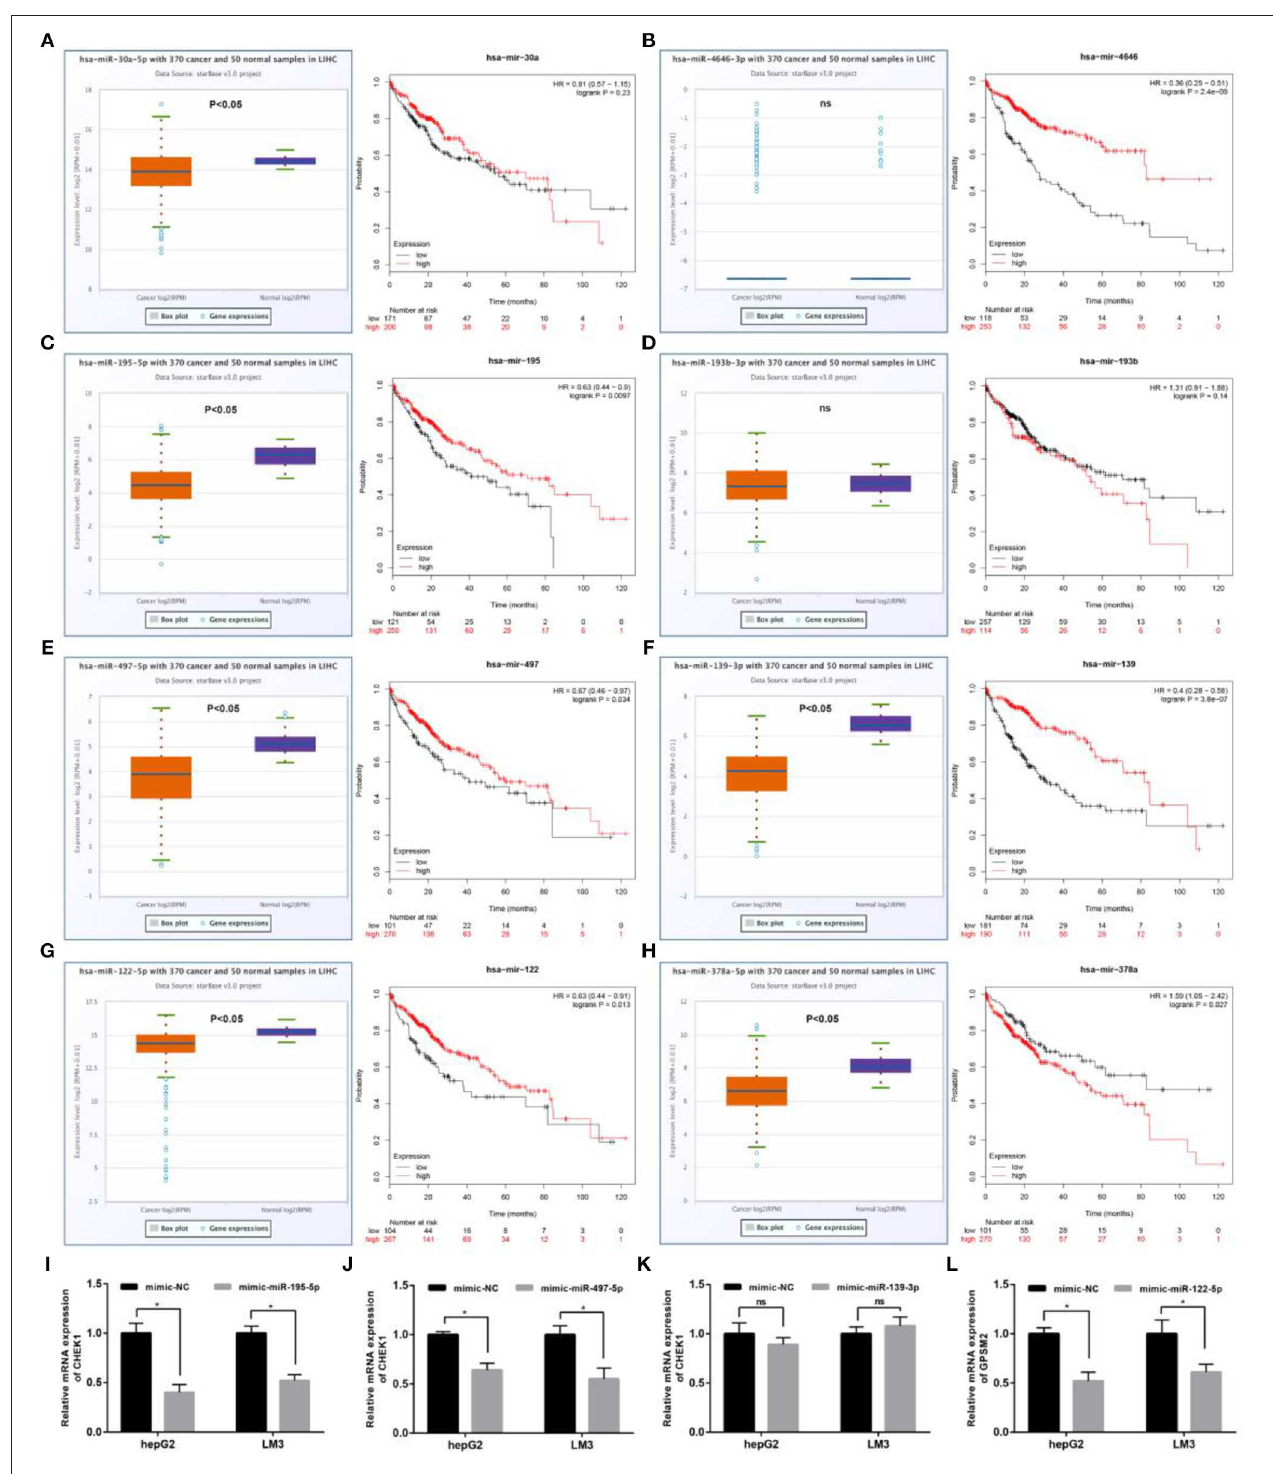
FIGURE 5 | Identification of the most potential miRNAs associated with prognosis of hepatocellular carcinoma. Expression and prognostic value of hsa-mir-30a-5p (A) , hsa-mir-4646-3p (B) , hsa-mir-195-5p (C) , hsa-mir-193b-3p (D) , hsa-mir-497-5p (E) , hsa-mir-139-3p (F) , hsa-mir-122-5p (G) , and hsa-mir-378a-5p (H) in hepatocellular carcinoma; (I) after overexpression of hsa-mir-195-5p, mRNA expression of CHEK1 was significantly decreased in hepG2 and LM3; (J) after overexpression of hsa-mir-497-5p, mRNA expression of CHEK1 was significantly decreased in hepG2 and LM3; (K) after overexpression of hsa-mir-139-3p, no significant downregulation of CHEK1 mRNA expression was observed in hepG2 and LM3; (L) after overexpression of hsa-mir-122-5p, mRNA expression of GPSM2 was significantly decreased in hepG2 and LM3. * P < 0.05.